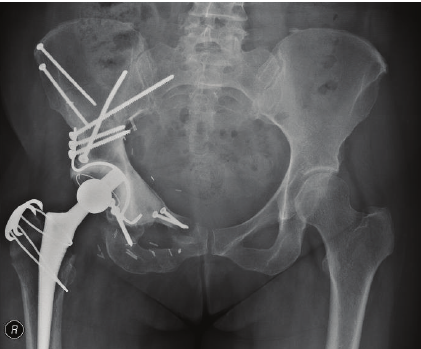
Figure 2: Postoperative X-ray at 6 months. Asymptomatic nonun- ion is seen at the ischial and pubic osteotomies. The configuration of screws and plates and screws through flanged acetabular cages was variable between